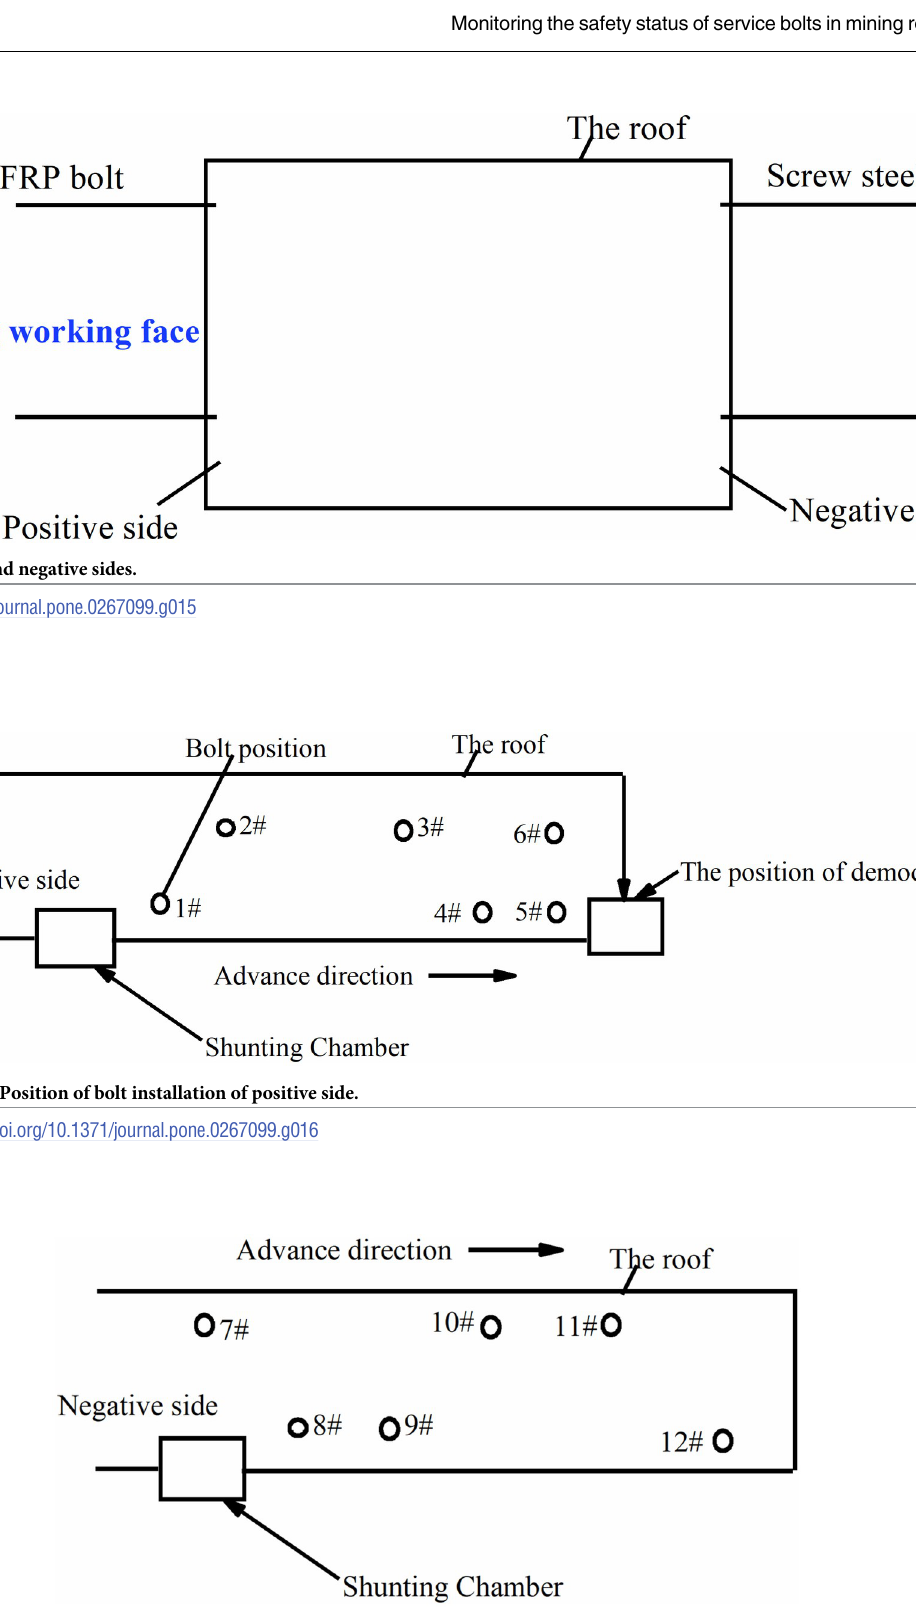
Fig 17. Position of bolt installation of negative side.